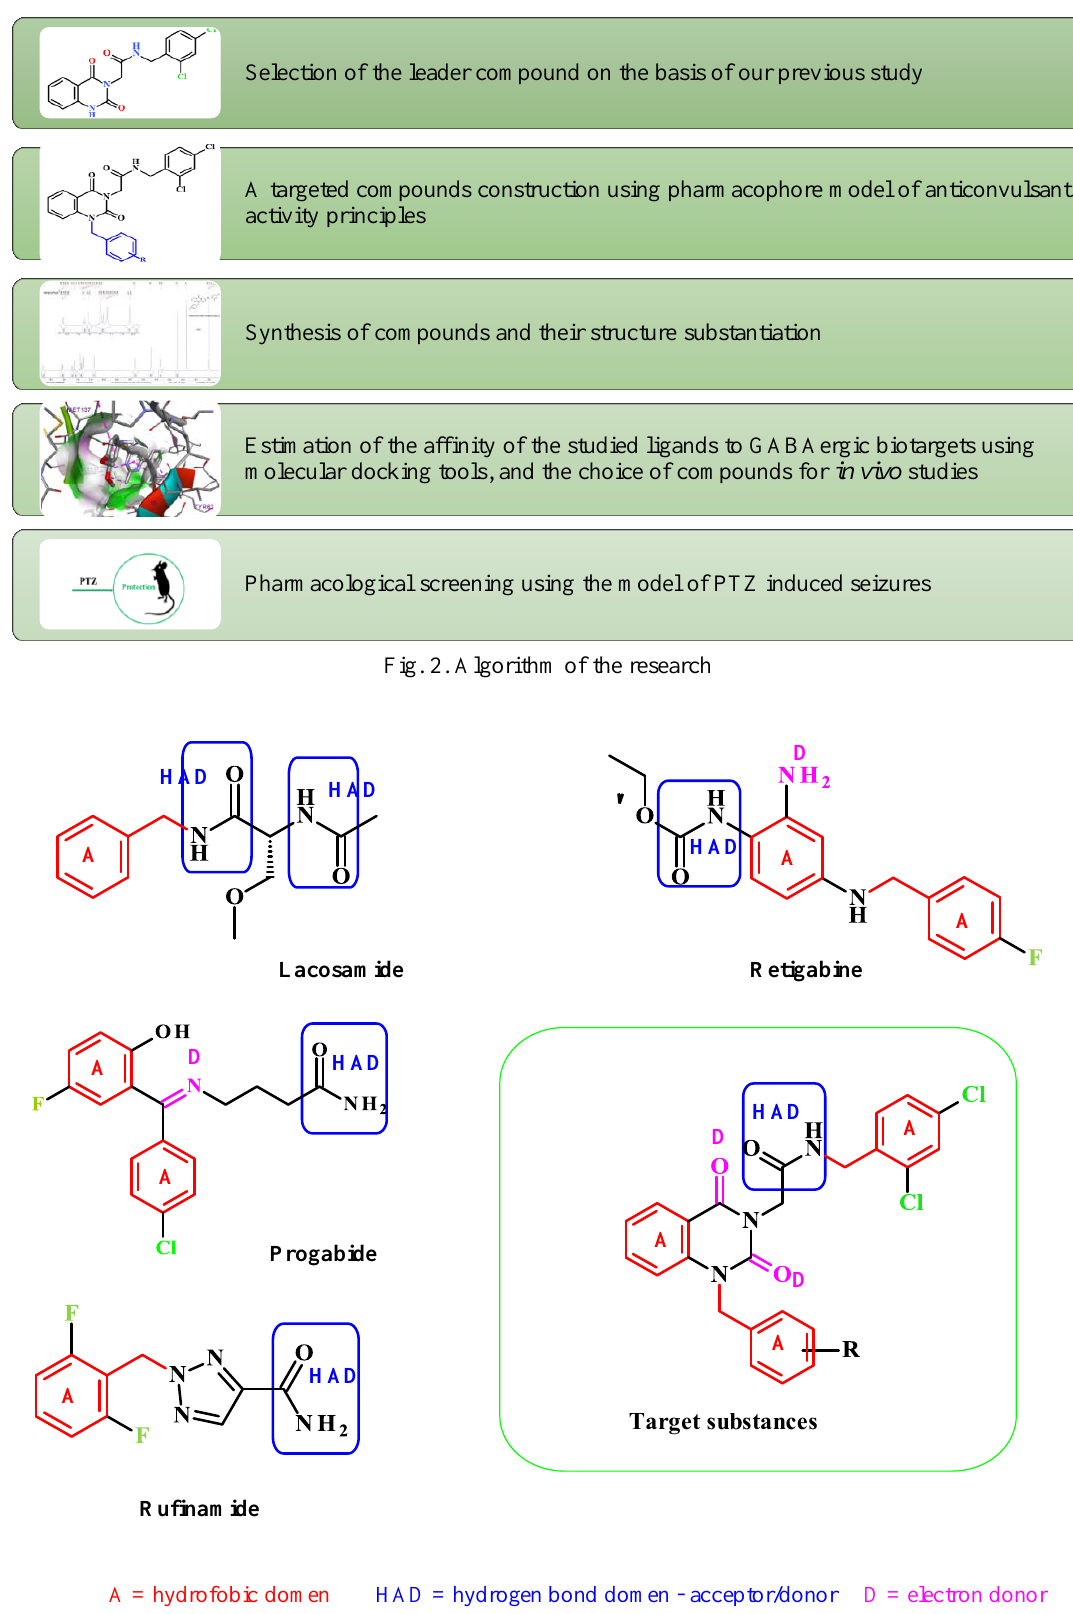
Fig. 3. Pharmacophore model principles of anticonvulsant activity on example of the modern AEDs and the targeted